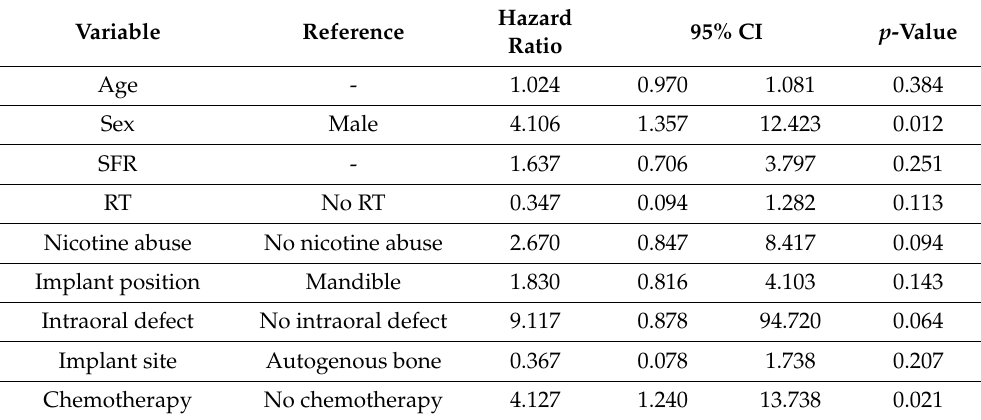
Table 2. Hazard ratios of demographic and clinical characteristics for multivariable analysis of implant